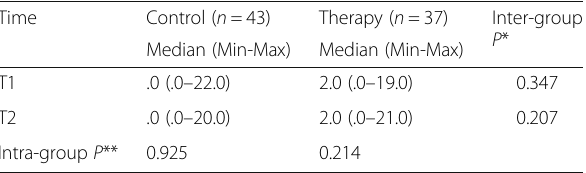
Table 2 Disease activity scores of SLE patients in control and therapy groups over time